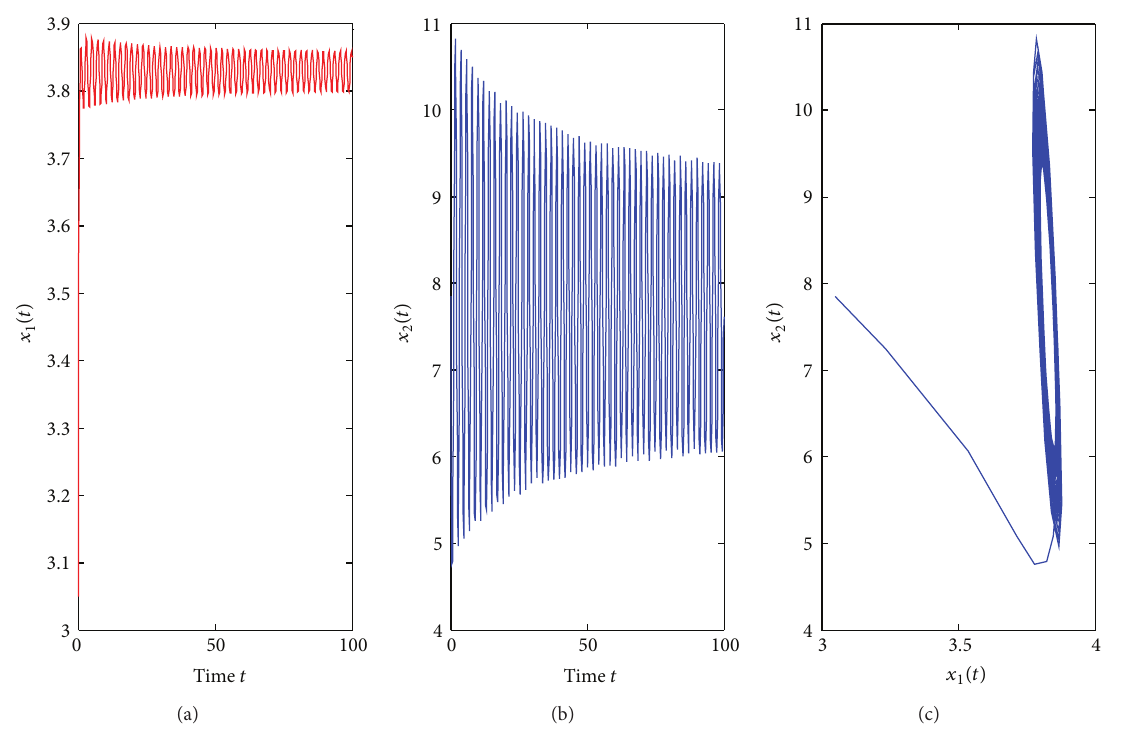
Figure 4: 𝐸 ∗ is unstable for 𝜏 2 = 0.505 > 𝜏 20 = 0.4912